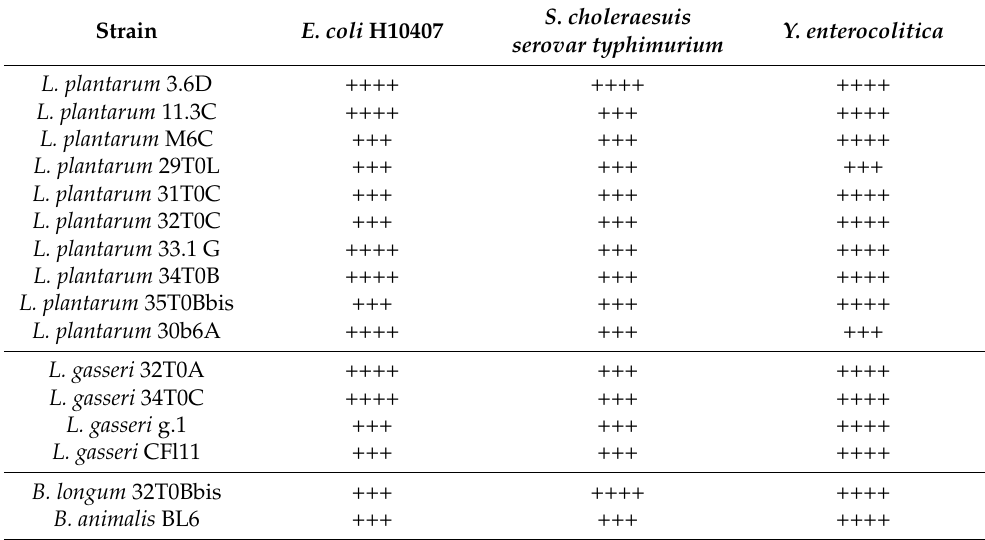
Table 5. Evaluation of the antagonistic activity of the Lactobacillus and Bifidobacterium strains isolated from breast milk and used in the present study against intestinal pathogenic